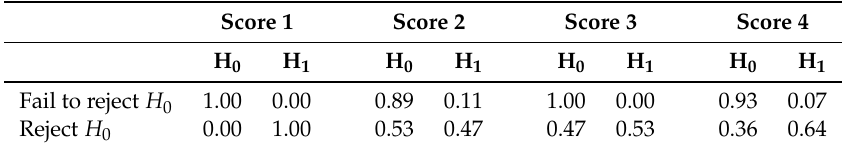
Table 10. True rate of false positives and false negatives for each of the four scores when the size of the samples to diagnose is ν = 50 and the sensors used are numbers 1,2,4,5,6 and